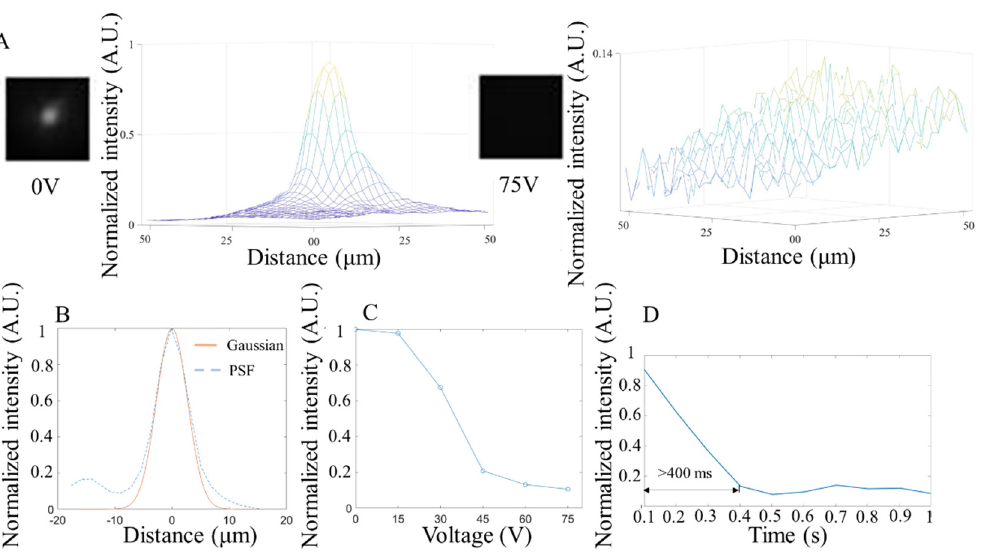
Figure 7. Characterization of NLC at 560 nm wavelength. ( A ). The microscope image of the NLC and the light intensity distribution color map at 0 V ( left ) and 75 V ( right ). ( B ). The NLC’s point spread function and Gaussian fitting curve at 0 V. ( C ). Average measurement of light intensity changes under different voltages. ( D ). Average response time (change from 90% to 10% of normalized light intensity step height) of the NLC under 75 V (n = 5).